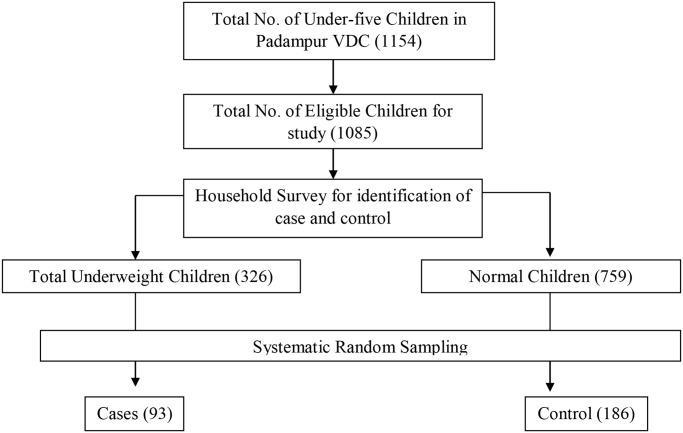
Sampling procedure for selection of cases and control.